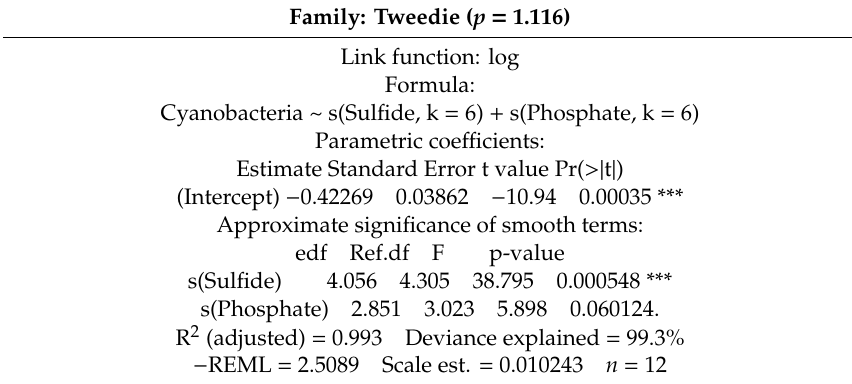
Table A1. Formulae, coe ffi cient and significant level of the GAM analysis. The used smoothing method was Restricted Maximum Likelihood (REML), k refers to knots and indicates the maximum number of turning points, edf refers to estimated degrees of freedom and indicates the turning points found in the smoothing process, Ref.df refers to reference degrees of freedom, F is the F value, the Pr( >| t | ) is the t value for the t test. Significance codes: 0 ‘***’ 0.001 ‘**’ 0.01 ‘*’ 0.05 ‘.’ 0.1 ‘ ’